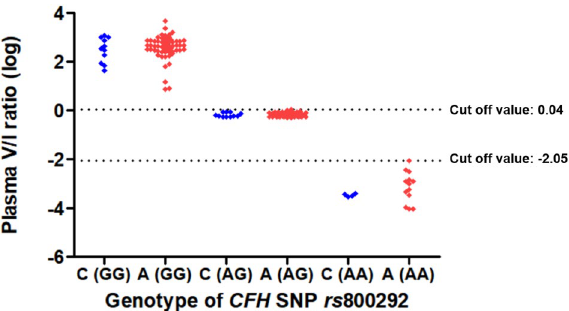
Figure 6. The distribution of logarithm plasma CFH valine/isoleucine variant protein ratio according to the genotype of complement factor H single nucleotide polymorphism rs 800292 and the presence of age-related macular degeneration. C, control; A, age-related macular degeneration; CFH, complement factor H; SNP, single nucleotide polymorphism; V, valine; I, isoleucine; log,